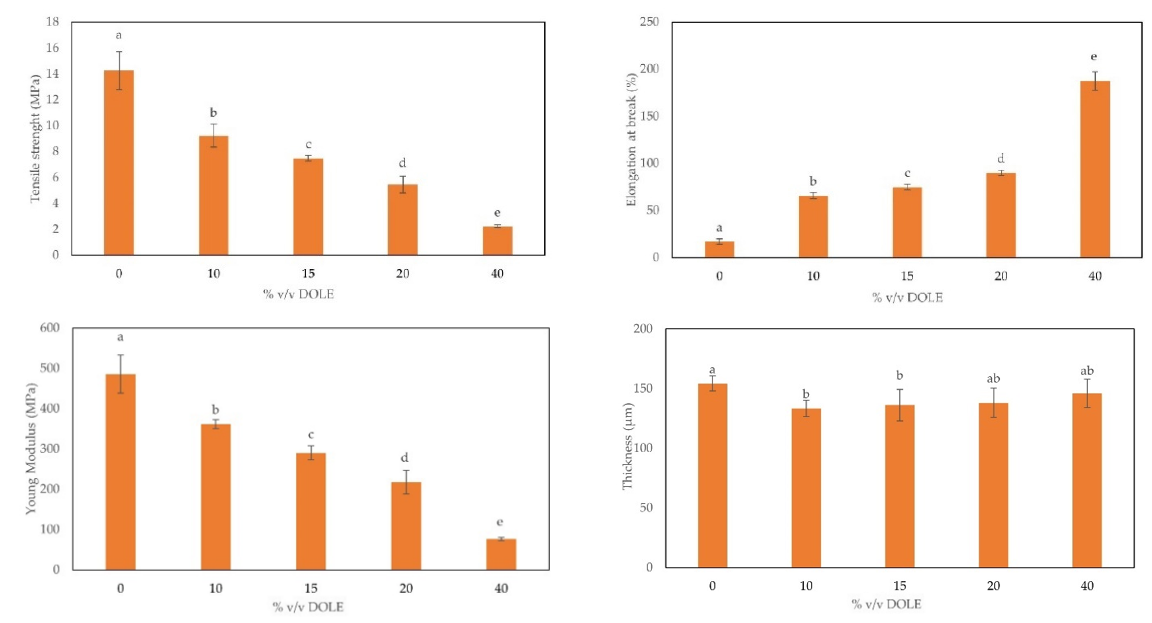
Figure 5. Properties of chitosan-based films with different % ( v / v ) of DOLE (0–40%). On the top: from left to right Tensile Strength and Elongation at Break. On the bottom: from left to right Young’s Modulus and Thickness. Different small letters (a–e) indicate significant differences among the values reported in each bar ( p <